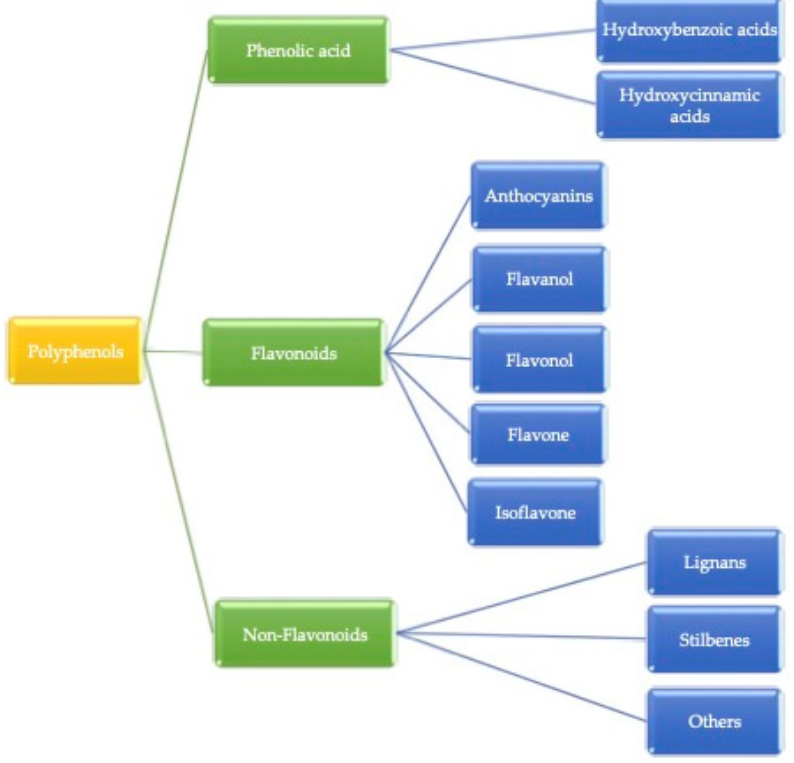
Figure 1. Classification of (poly)phenols.